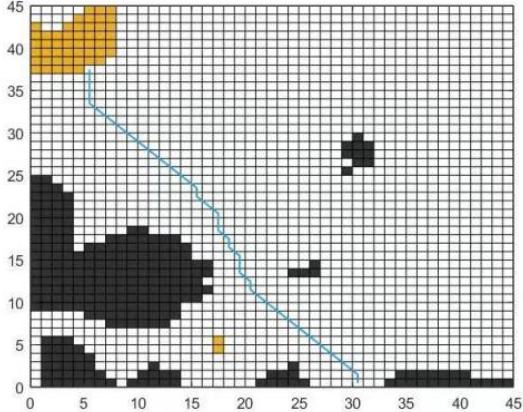
Figure 5. The result of company A.